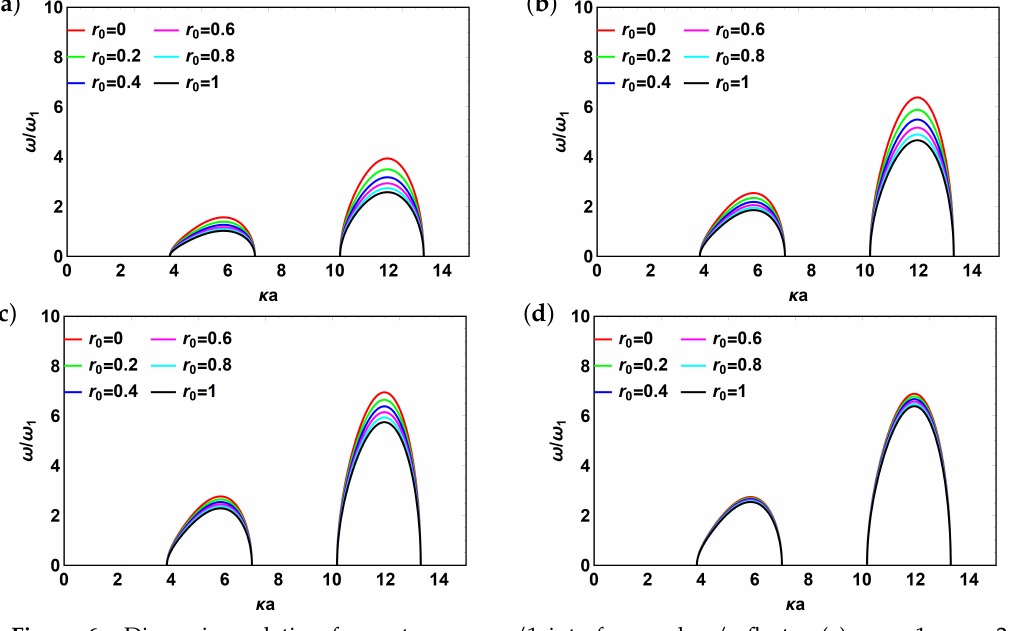
Figure 6. Dispersion relation for metascreen w/1 interface and w/reflector ( a ) q = 1, p = 2; ( b ) q = 1, p = 4; ( c ) q = 1, p = 6; ( d ) q = 1, p = 10. For all plots n = 1, r 0 = 0.5, kh (cid:28) 1, δ (cid:28) 1. “Positive” branch only is shown.